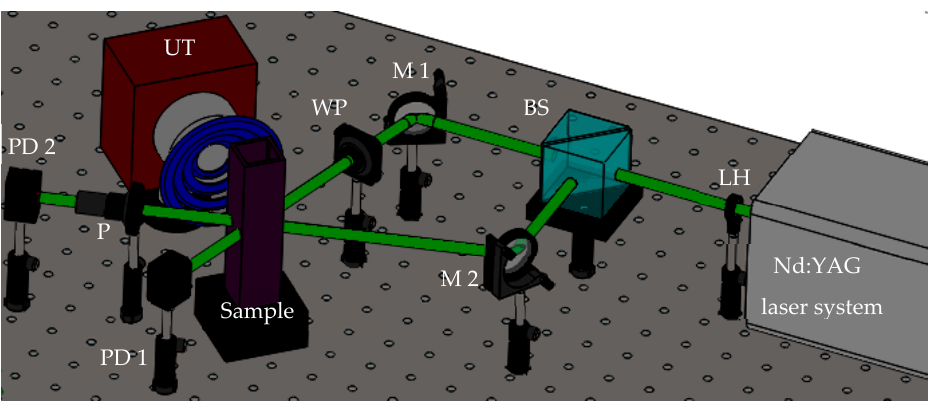
Figure 2. Acousto-optic explorations by the assistance of the two-wave mixing configuration.